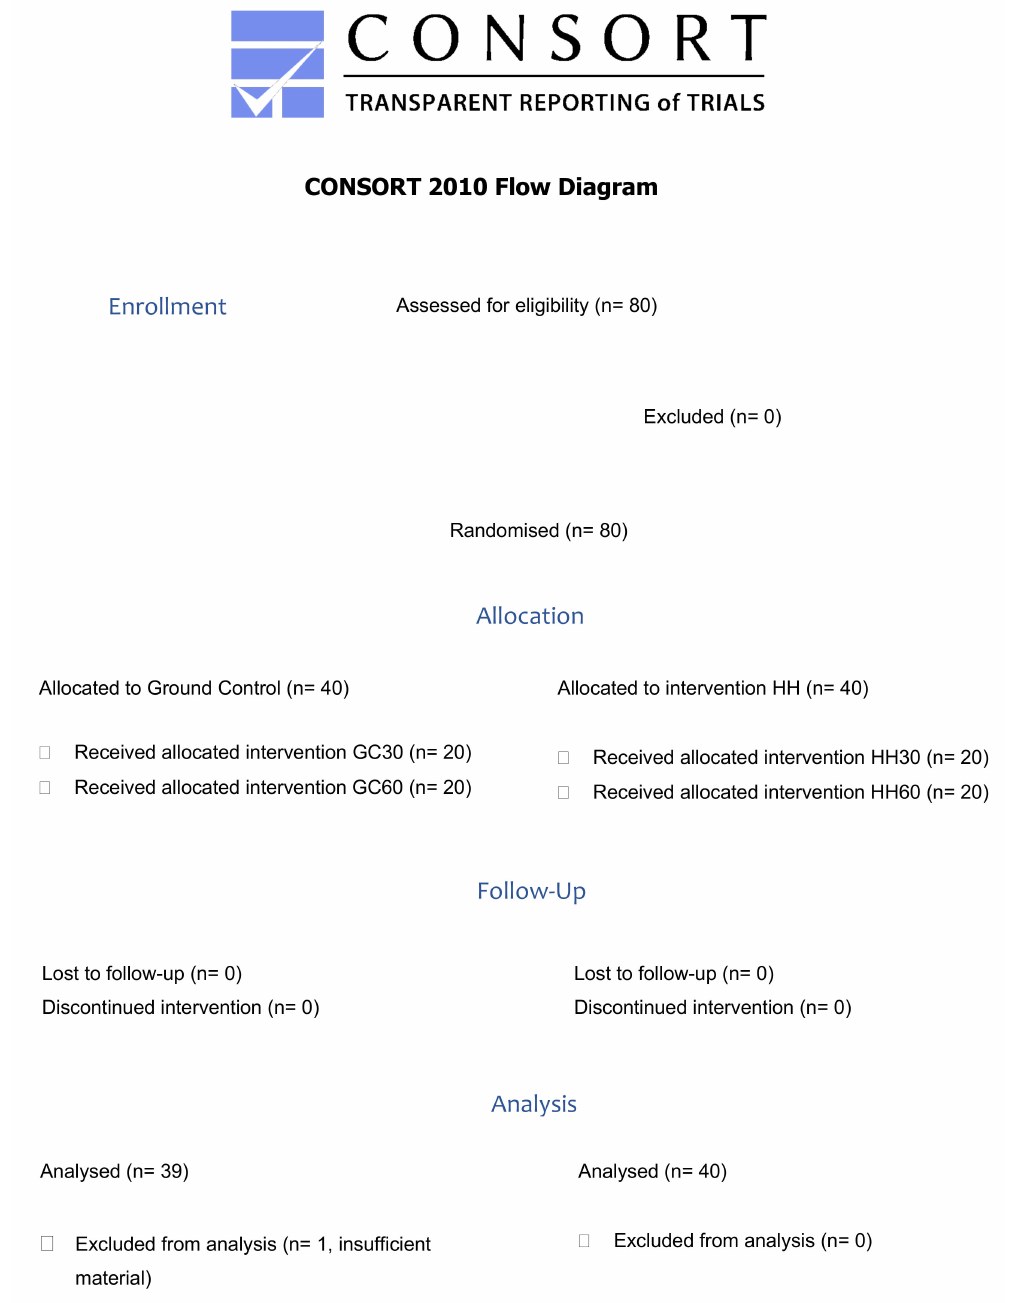
Figure 15. Consort 2010 Flow